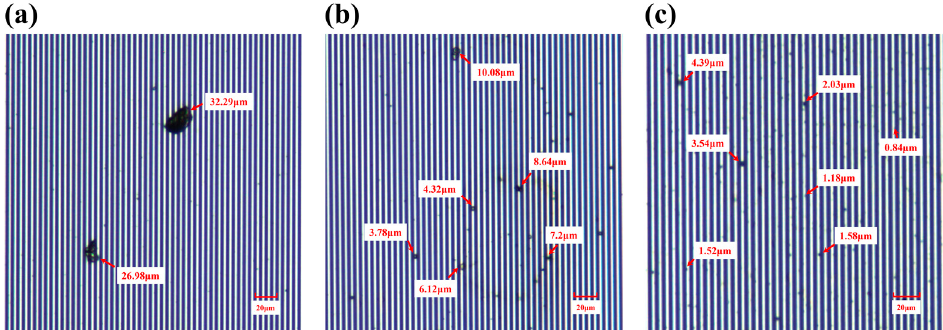
Figure 17. Photograph of the SAWR’s surface under microscope: ( a ) LCP stage; ( b ) PM 2.5 – 10 stage; ( c ) PM 1 – 2.5 stage.